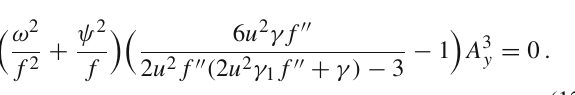
Table 1 The critical temperature T c for different coupling parameter γ . Here γ = 0 1 γ − 1 / 12 0 1 / 12 T c 0 . 0569 0 . 0654 0 . 0854 Table 2 The critical temperature T c for different coupling parameter γ γ = 0 1 . Here γ − 0 . 02 0 0 . 02 1 T c 0 . 0595 0 . 0654 0 . 0942